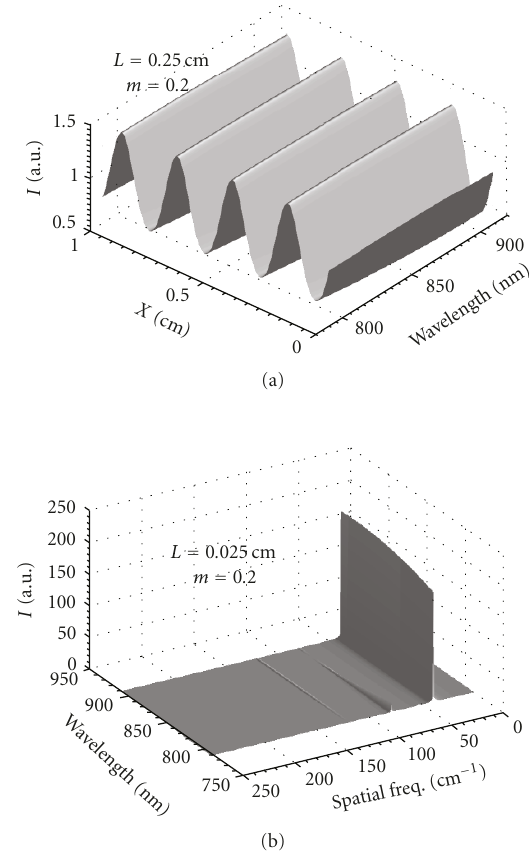
Figure 3: The intensity distribution and spatial frequency spectrum of the light transmitted by a sinusoidal phase grating with L = 0 . 025cm in the Fresnel zone as a function of the wavelength at z = 10 . 5cm for a plane-wave illumination. For convenience, the part of the spectrum at the fundamental frequency is